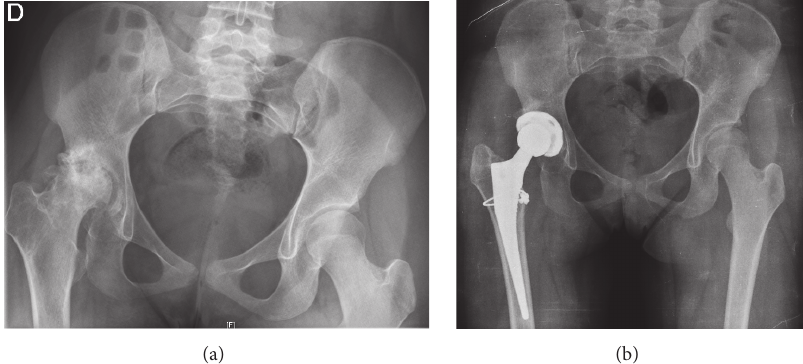
Figure 1: Simple radiology of hip before and after the